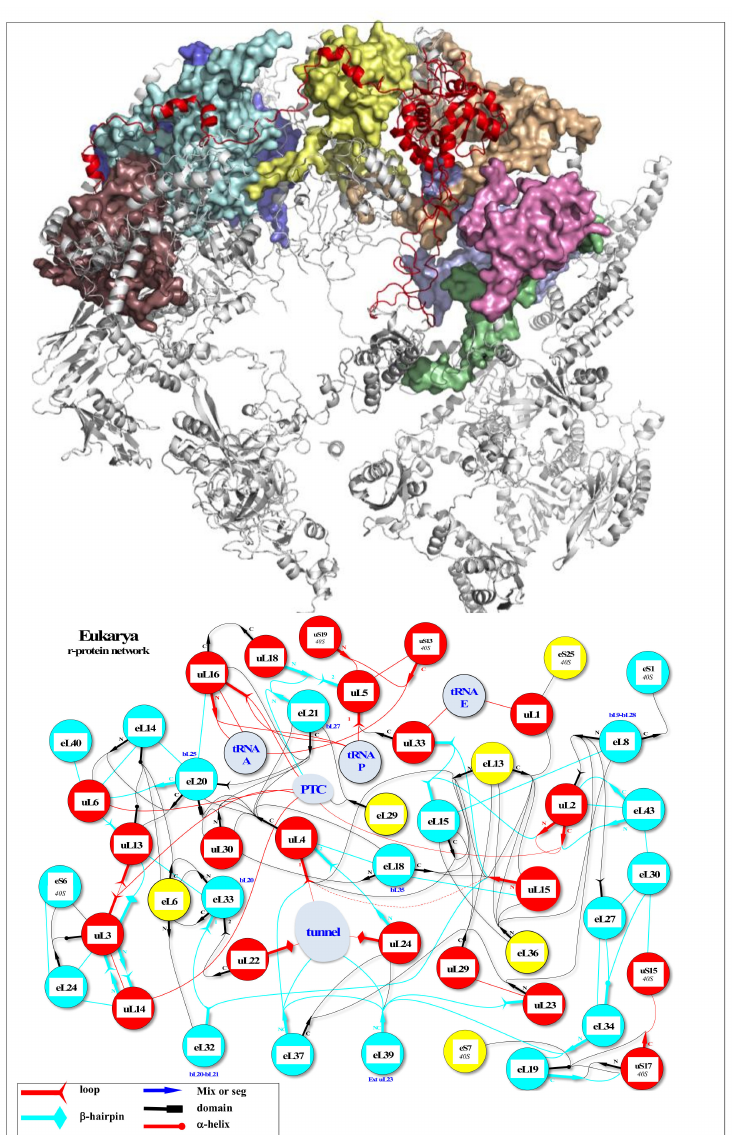
Figure 2. r-protein networks in the large subunit of the eukaryotic ribosome. (Top) Cartoon represen- tation of the large subunit of the eukaryotic ribosome (pdb_id: 4v88) [55]. The protein hub uL4 is represented in red, and its numerous partners are represented by coloured surfaces. (Bottom) Evolu- tion of the r-protein network by accretion around a universal network (red proteins): the r-proteins and their extensions are represented according to their evolutionary status. Red: universal (common to bacteria, archaea and eukarya); cyan: archaea; yellow: eukarya. Coloured thin lines symbolise an interaction between the r-protein extensions (the legend of the line codes for the extensions is indicated in the box). Lines between two circles symbolise an interaction between two globular domains. The colours of the lines follow the code for the evolutionary status described above, except for eukarya-specific connections that are represented with black lines for clarity. “N” or “C” indicate if the seg or mix are N-terminal or C-terminal extensions. NC indicates proteins without a globular domain (uS14, eL29, eS30, eL37 and eL39). Functional sites (PTC, Tunnel, tRNAs and mRNA) are represented in light blue. The names of bacterial proteins, which, by convergence, occupy a position similar to that of eukaryotic or archaeal r-proteins are shown in blue below the